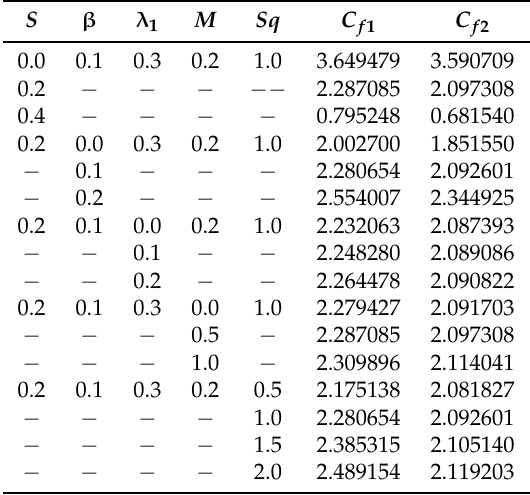
Table 4. Skin friction coefficient at the lower and upper disks via S , β , λ 1 , M and Sq .